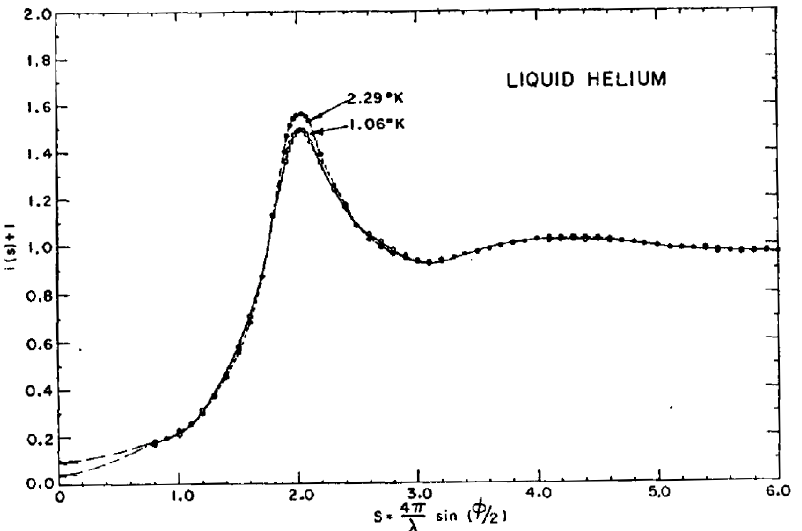
Figure 39. The liquid structure factor, S(Q), for liquid helium under its normal vapor pressure at 2.29 °K (above the λ -point) shown by closed circles and 1.06 °K (below the λ -point) shown by open circles. The effect of the λ -transition is a lowering and a slight broadening of the main maximum. This figure is taken from Figure 2 of ref. [98]. Copyright by the American Physical Society.